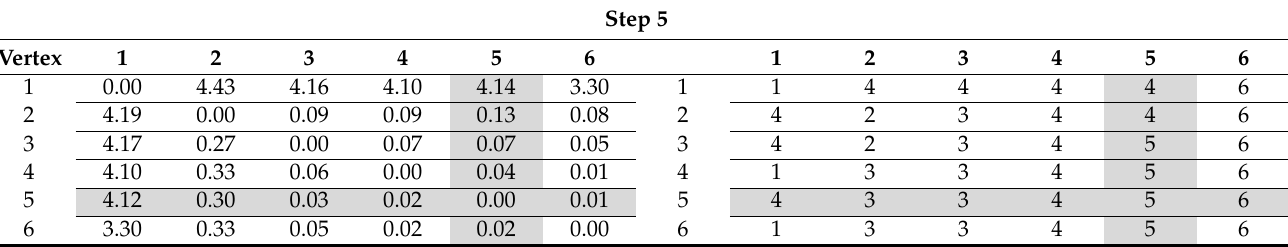
Table A14. The step 5 graphical process of the best search and rescue